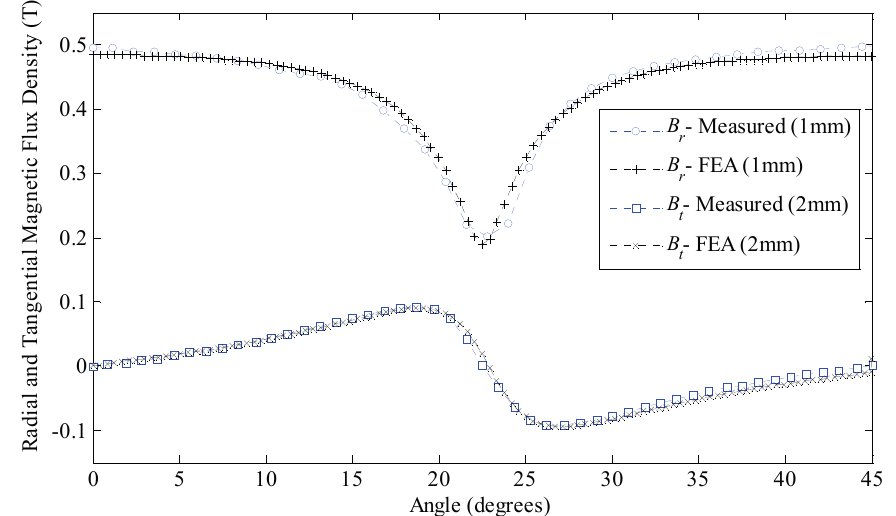
Figure 18. Results of FEA and measurements of normal B of magnetic flux density as measured in the air gap of the